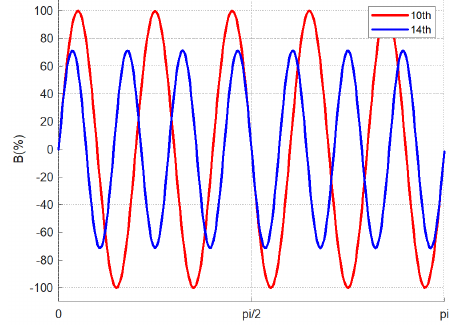
Figure 5. Stator flux-density distribution due to the dominant